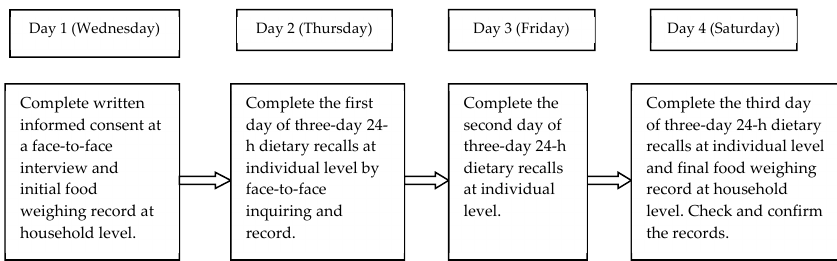
Figure 2. The representative flow of dietary survey in CNNHS 2010–2012.